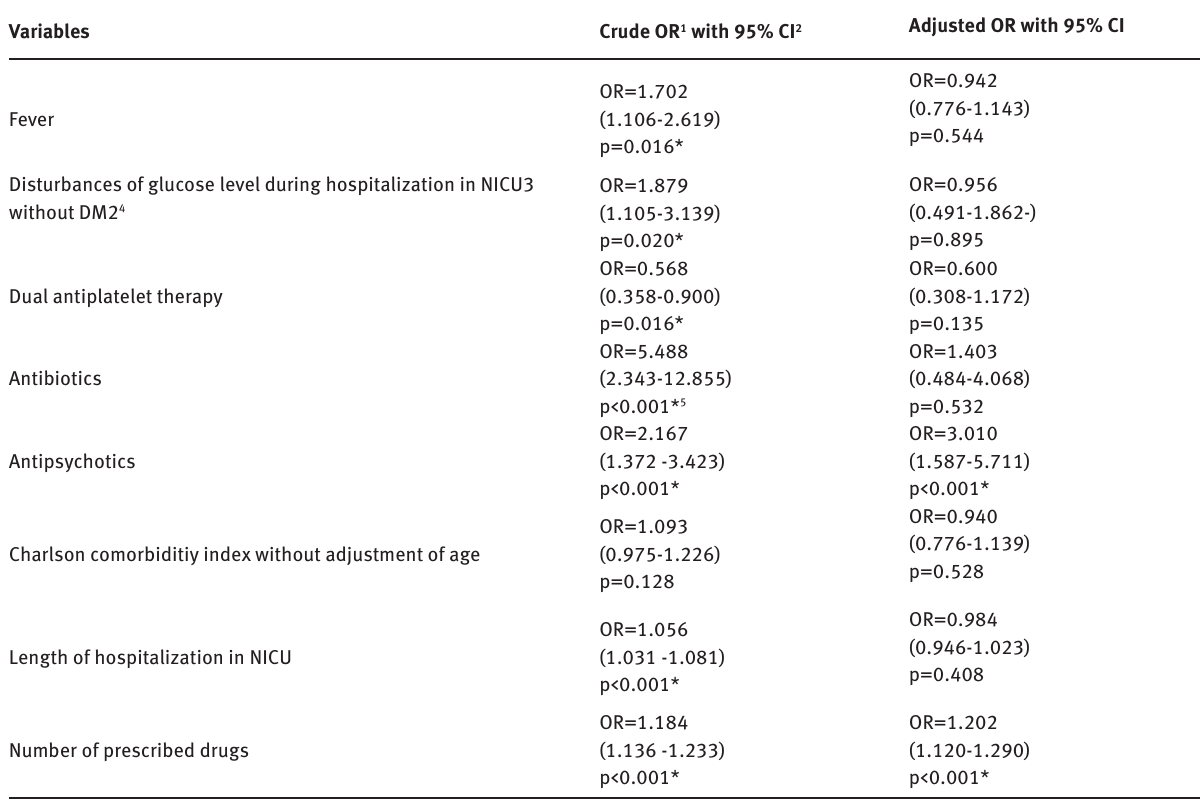
Table 5: Significant risk factors for potentially contraindicated drug-drug interactions (pCDDI) in stroke patients.